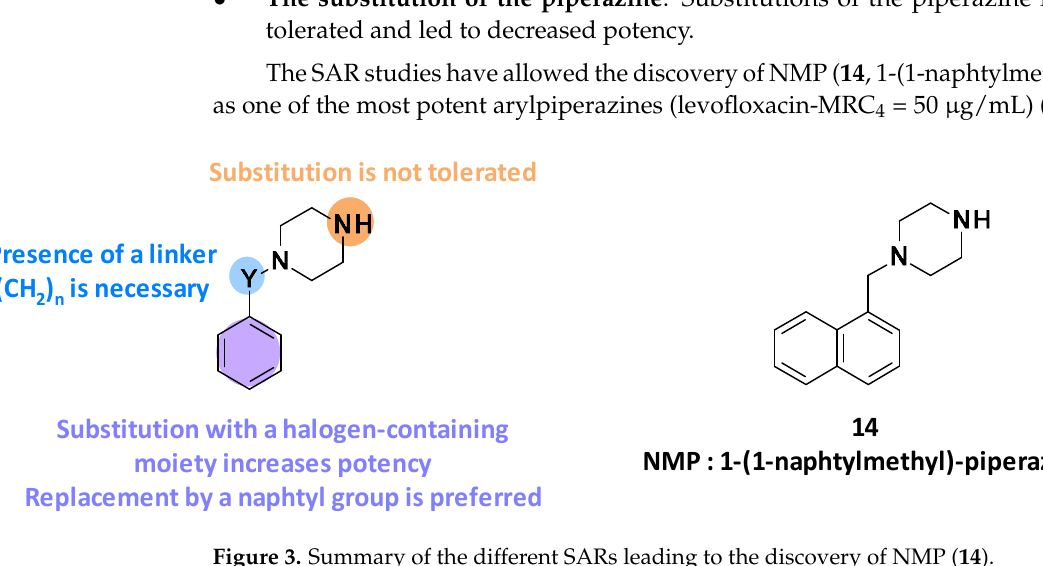
Figure 3. Summary of the different SARs leading to the discovery of NMP ( 14 ) .